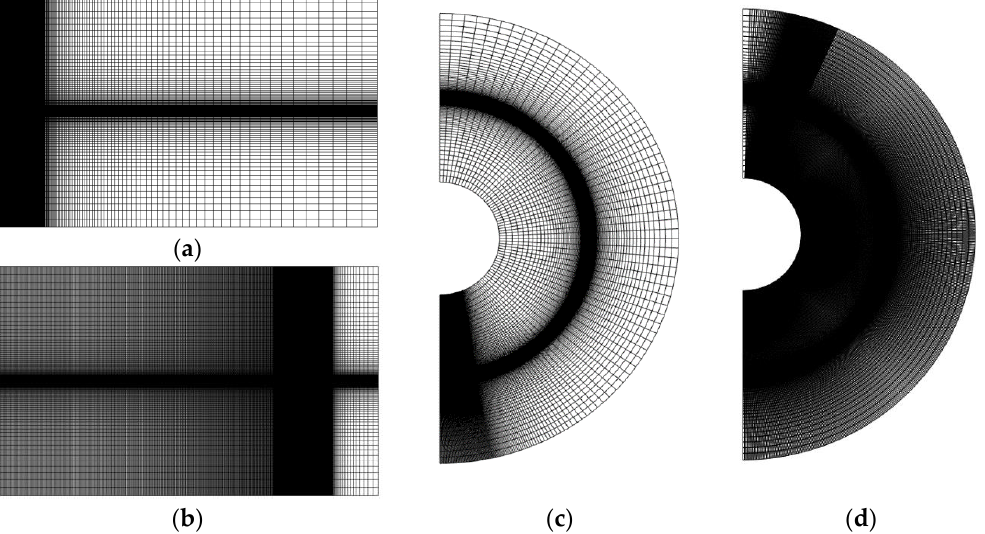
Figure 3. Mesh topologies (top view). ( a ) Initial mesh, ( b ) Renewal of mesh , ( c ) Initial mesh, ( d ) Renewal of mesh.